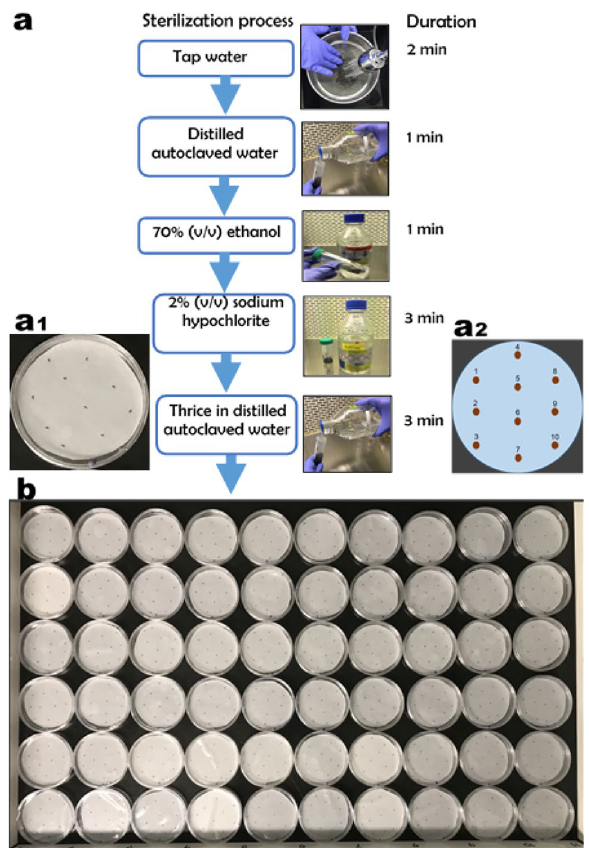
Figure 1. ( a ) Summary of sterilization process of A. africana seeds. ( a 1) Arrangement of A. africana seeds in a Petri dish ( a 2) Illustration of arrangement of A. africana seeds in a Petri dish ( b ) Seeds of A. africana in Petri dishes incubated in a thermogradient germinator at different temperatures (1–17.6 °C, 2–18.7 °C, 3–19.8 °C, 4–20.9 °C, 5–22.0 °C, 6–23.1 °C, 7–24.2 °C, 8–25.3 °C, 9–26.4 and 10–27.5